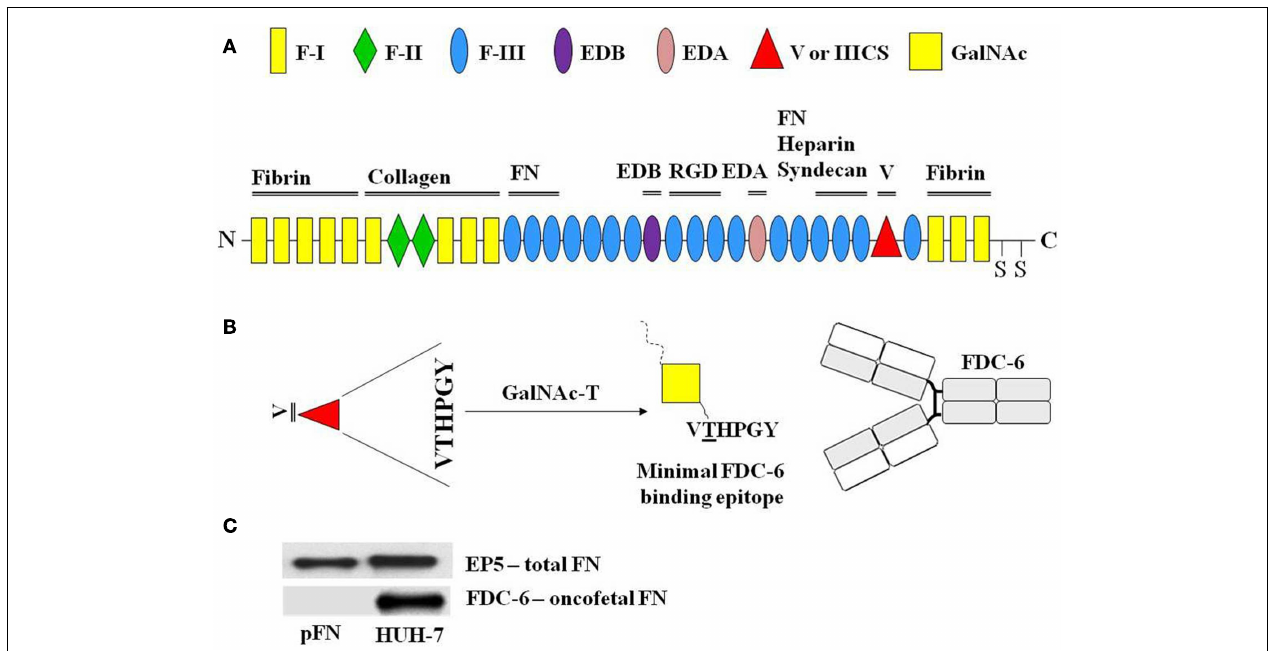
different IIICS variants may be generated (V0,V64,V89,V95, andV120). ExcludingV0, all others variants may hold the hexapeptide (VTHPGY) required to create the O -glycosylated onfFN, which is produced from the addition of a GalNAc unit at theThr residue of the hexapeptide (V T HPGY) by a specific GalNAc-T. It creates the oncofetal epitope required for FDC-6 binding (B) . As described, FDC-6 reacts exclusively with the O -glycosylated onfFN, but not with non- O -glycosylated FN or plasma FN (pFN) (C)